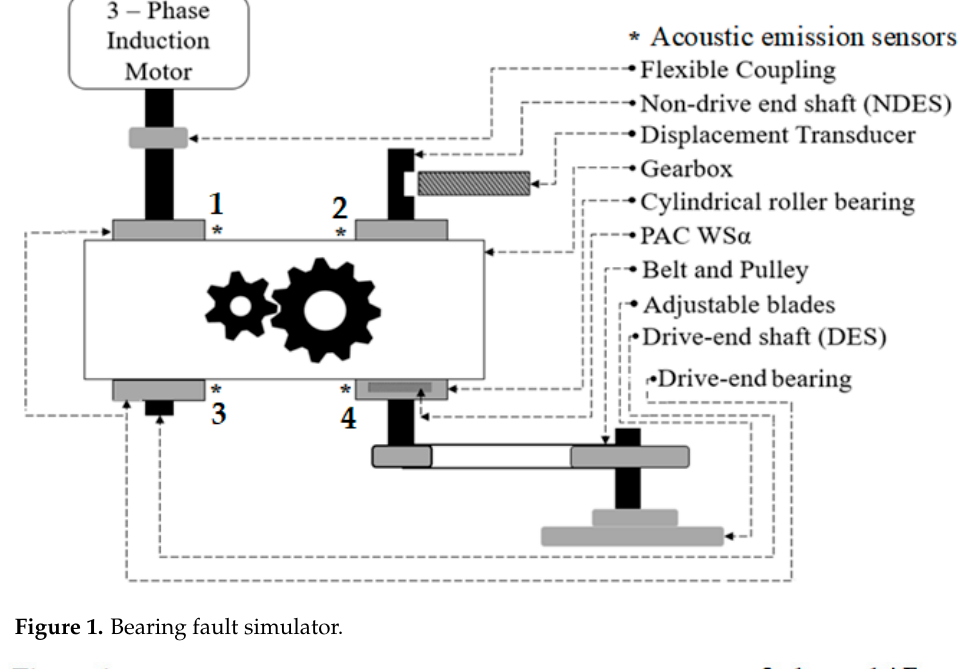
Figure 1. Bearing fault simulator.